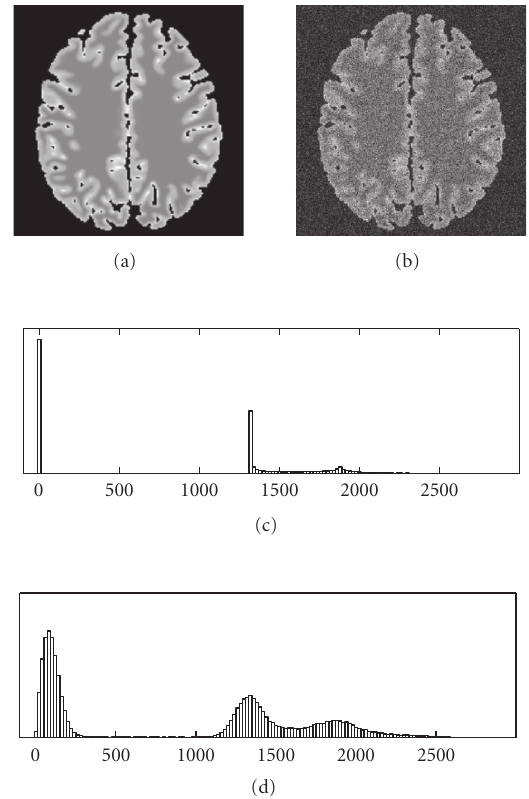
Figure 3: (a) A noise-free T2-weighted MR image. (b) Image (a) with Rician noise of σ = 81 . 67 (SNR 10 dB). The histogram of a noise-free T2 ∗ -weighted MR image (c) and of the same image with Rician noise of σ = 81 . 67, SNR = 10 dB